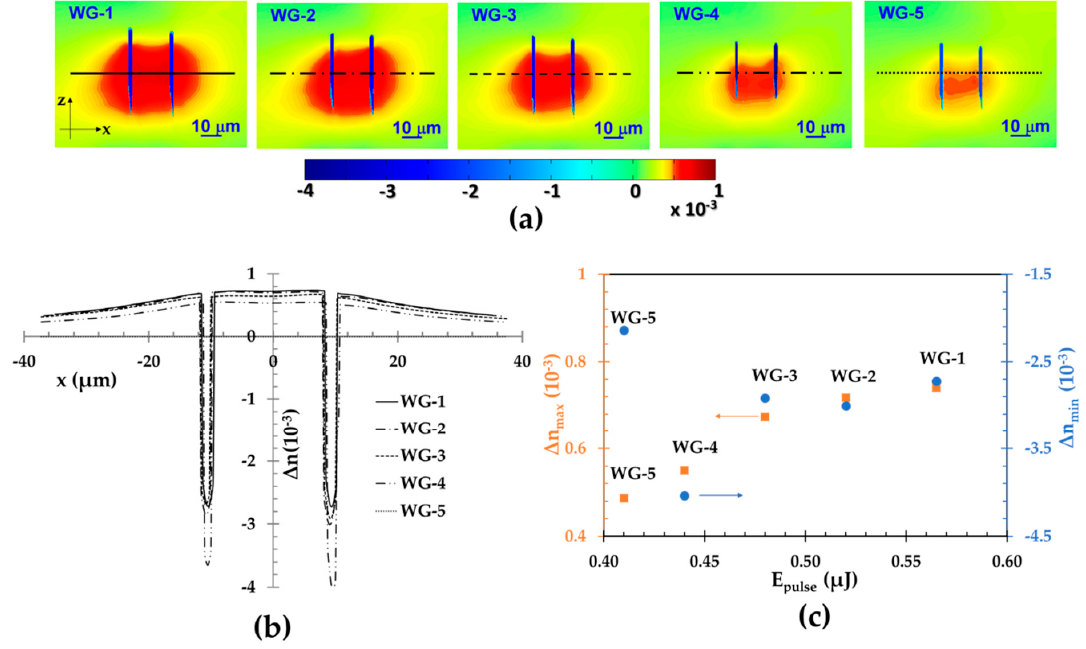
Figure 2. (a) The 2D longitudinal cross-sections of the spatial refractive index change (RIC) map of all all the five waveguides. ( b ) Line profile of the RIC for all the waveguides. ( c ) The minimum and the five waveguides. (b) Line profile of the RIC for all the waveguides. (c) The minimum and maximum maximum RIC values of the RIC values of the waveguides.